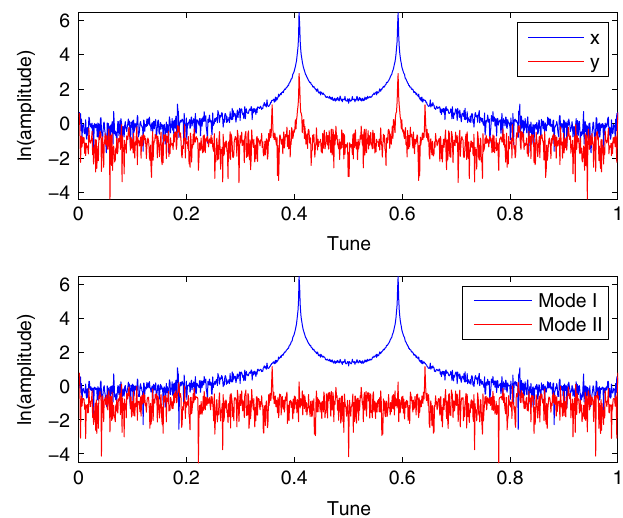
FIG. 8. Fourier spectra of beam position coordinates returned by BPM 7W over 1024 consecutive turns, with mode I resonant excitation. Note that the (fractional part of the) mode I tune is 0.59, and the (fractional part of the) mode II tune is 0.63.